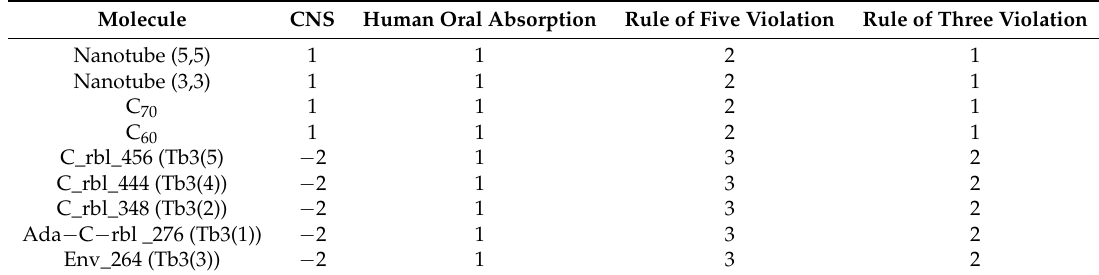
Table 6. Drug − like properties of rhombellane